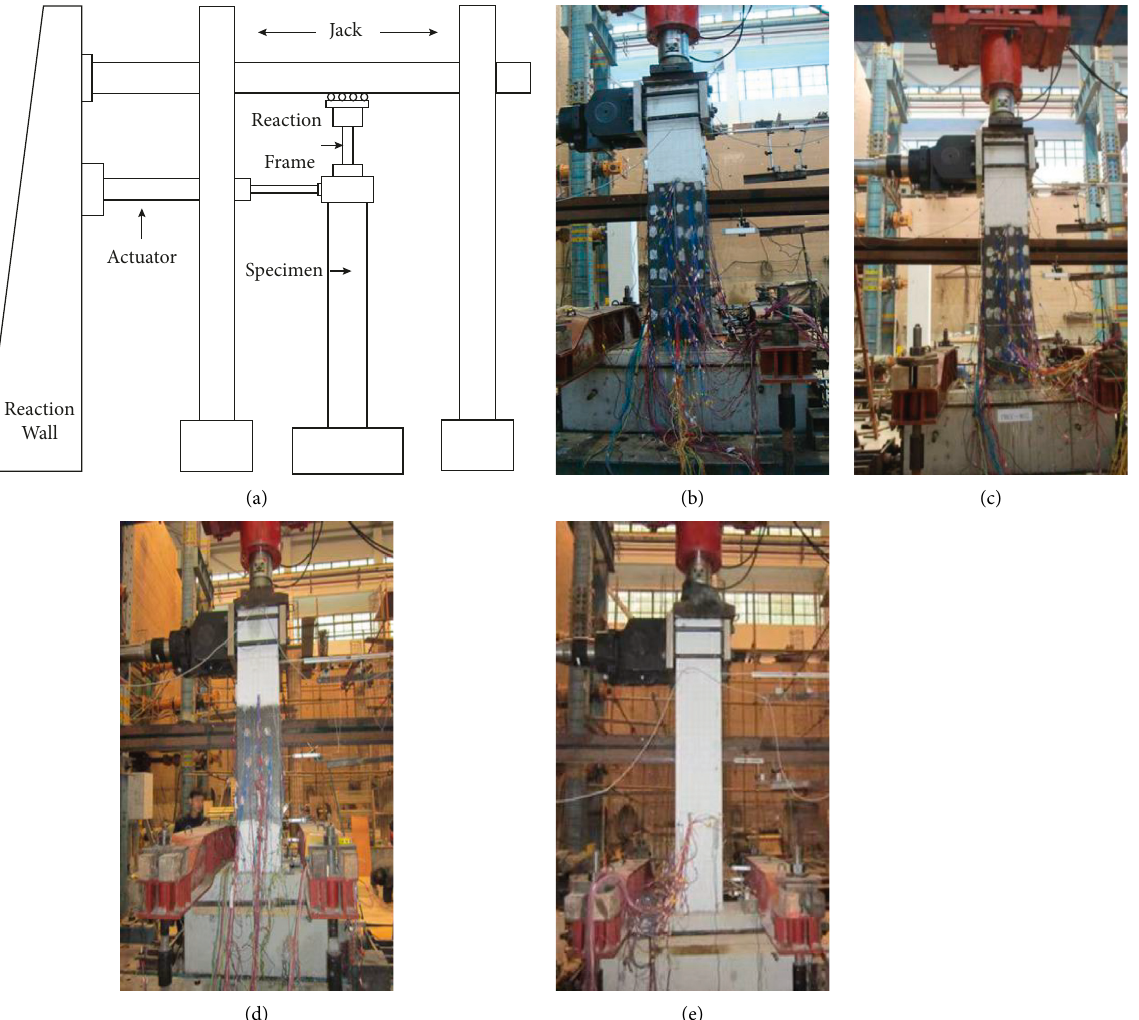
Figure 2: Loading device and installation and fixing of specimens. (a) Schematic diagram of the loading device. (b) W01. (c) W02. (d) W03. (e) XJ-01.